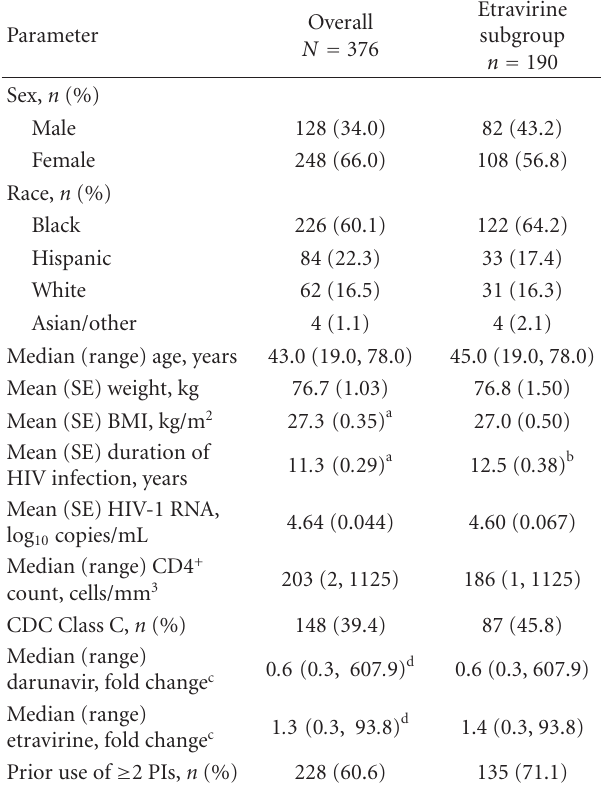
Table 1: Baseline demographics and disease characteristics for the pharmacokinetic population (overall and etravirine